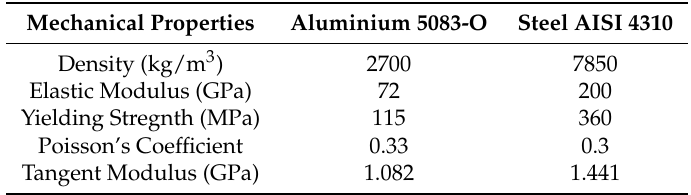
Table 1. Mechanical properties of the aluminium and steel used in our analysis. The values were taken after a general survey on reference